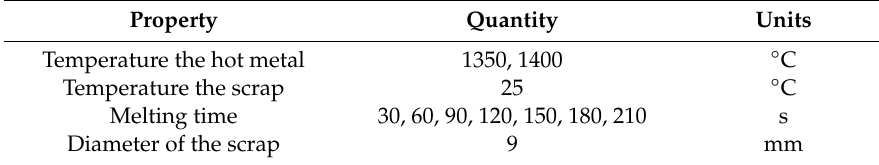
Table 2. The operation parameters used in the